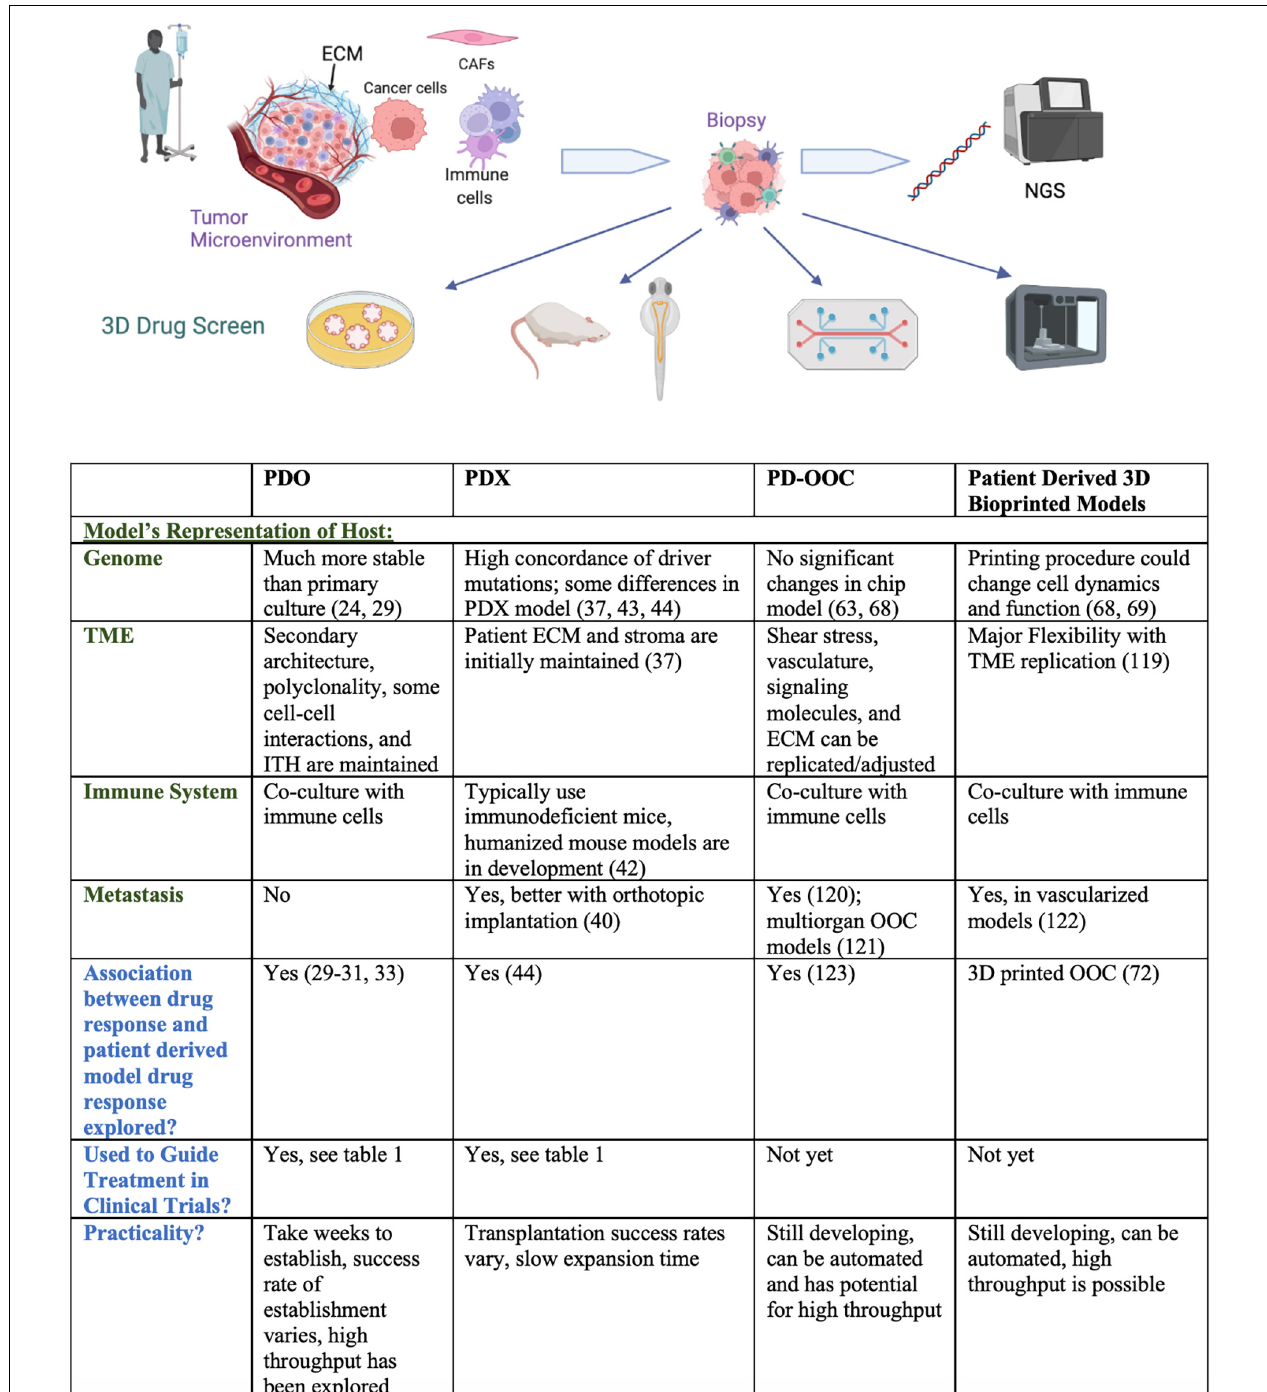
FIGURE 1 | Comparison of 3D patient-derived drug screening platforms. Pictogram was created with Biorender.com.